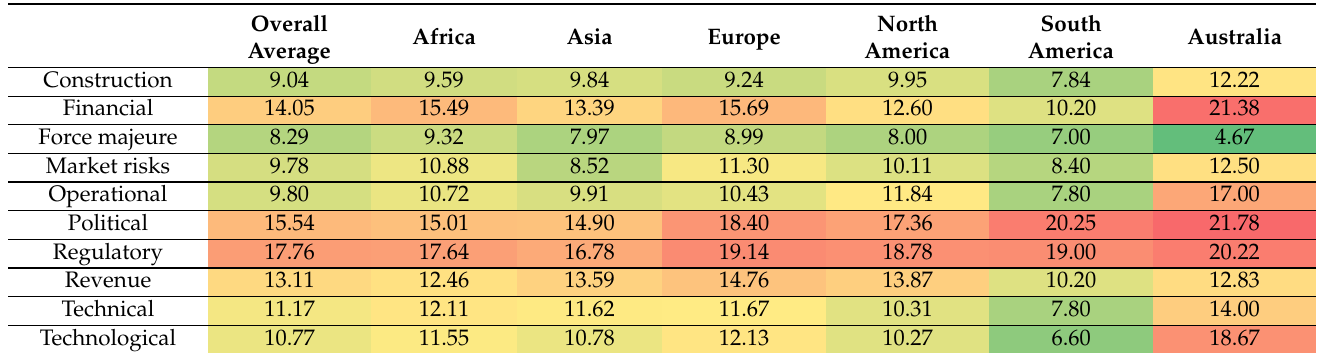
Table 4. Risk severity of every barrier across the six